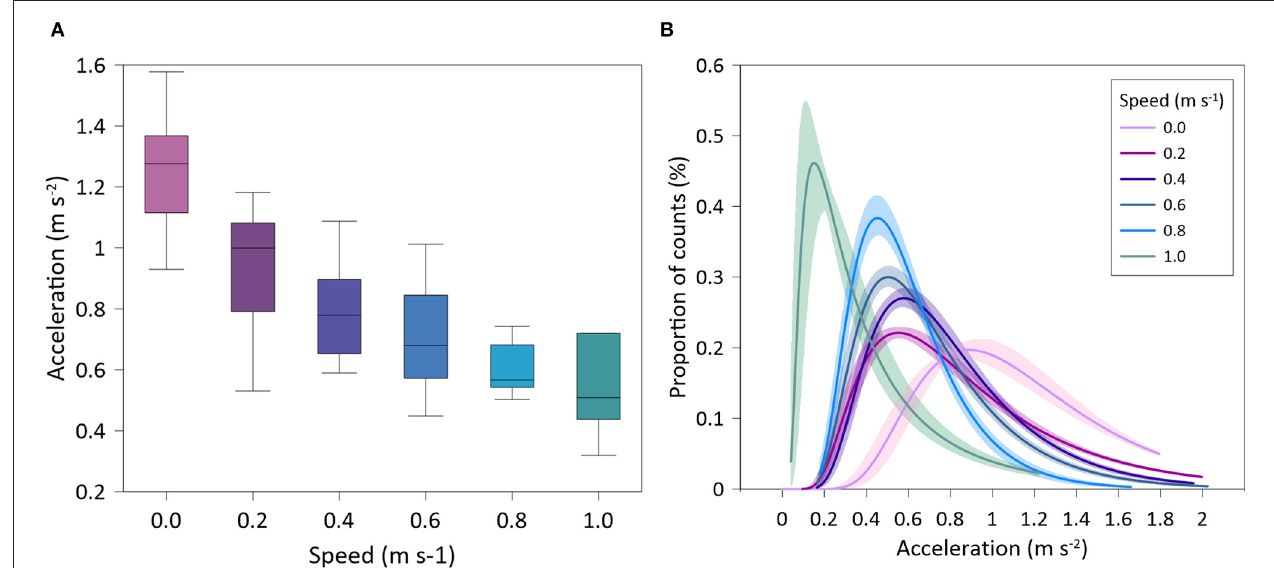
FIGURE 3 | Accelerations of tagged Sparus aurata at different water speeds. (A) Box-plot of mean values; (B) Inverse Gaussian lines fitted on proportional data distribution.